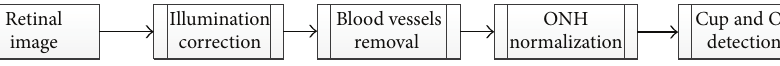
Figure 33: Flowchart for algorithm proposed in